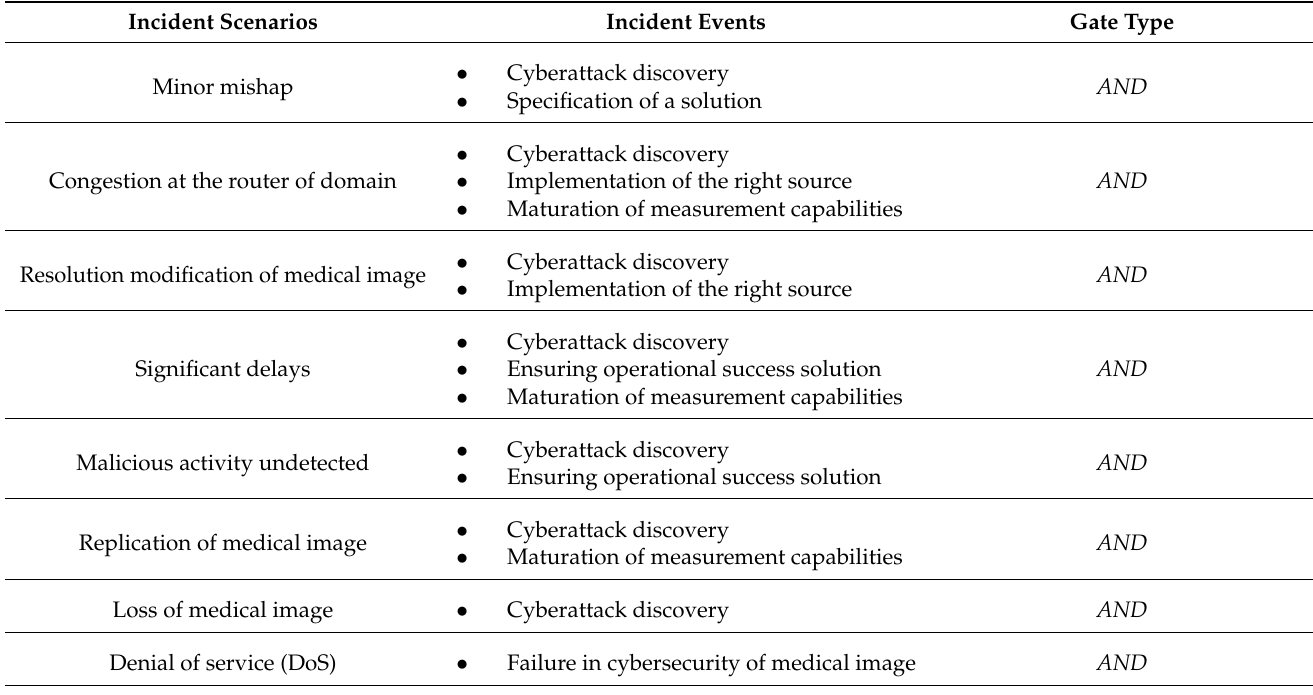
Table 5. Failure events of cyberattacks in telemedicine.